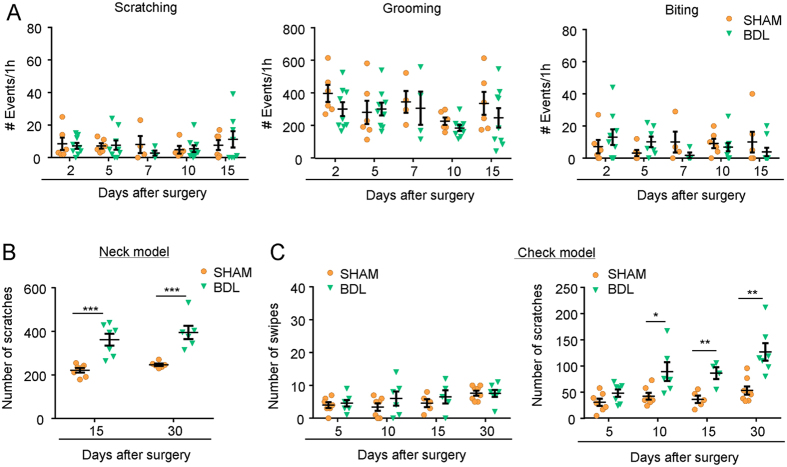
5-HT-induced itch was enhanced in BDL rats compared to sham control.(A) Spontaneous itch-related behaviors, such as scratching, grooming, and biting, were not changed in BDL rats compared to sham group (n = 6 per group). (B) The scratching behavior induced by i.d. injection of 5-HT (200 μg) into the nape of the neck of rats was significantly increased in BDL rats compared to sham group (n = 6 per group). (C) The scratching behavior, but not wiping behavior, induced by i.d. injection of 5-HT (200 μg) into the cheek of rats was significantly increased in BDL rats compared to sham group (n = 6 per group) (*P < 0.05, **P < 0.01, ***P < 0.001 versus sham values and analyzed by two-way ANOVA followed by Bonferroni’s test).